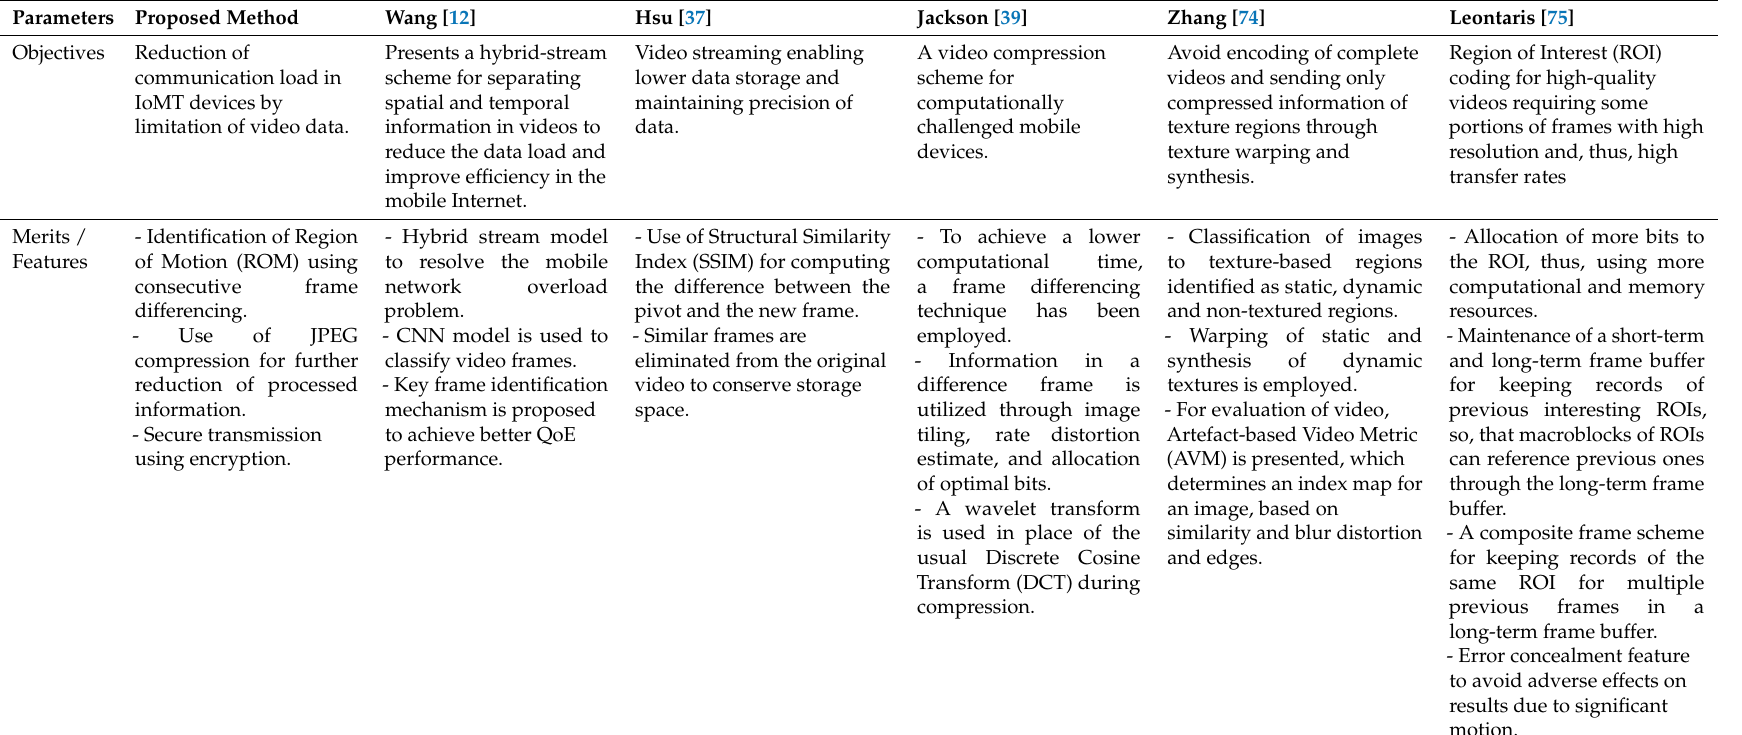
Table 4. Comparative analysis of the proposed method and prior